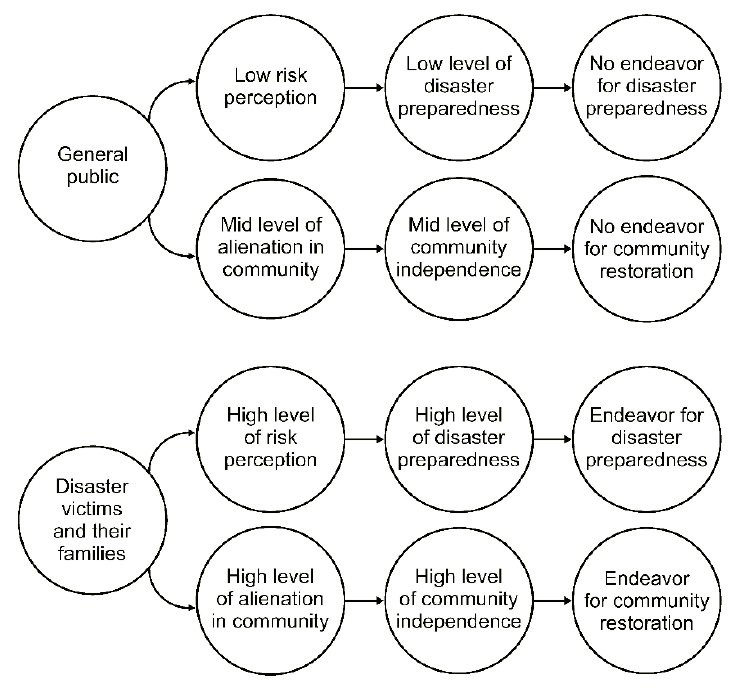
Figure 1. Roles of disaster victims and their families and the general public in disaster preparedness .